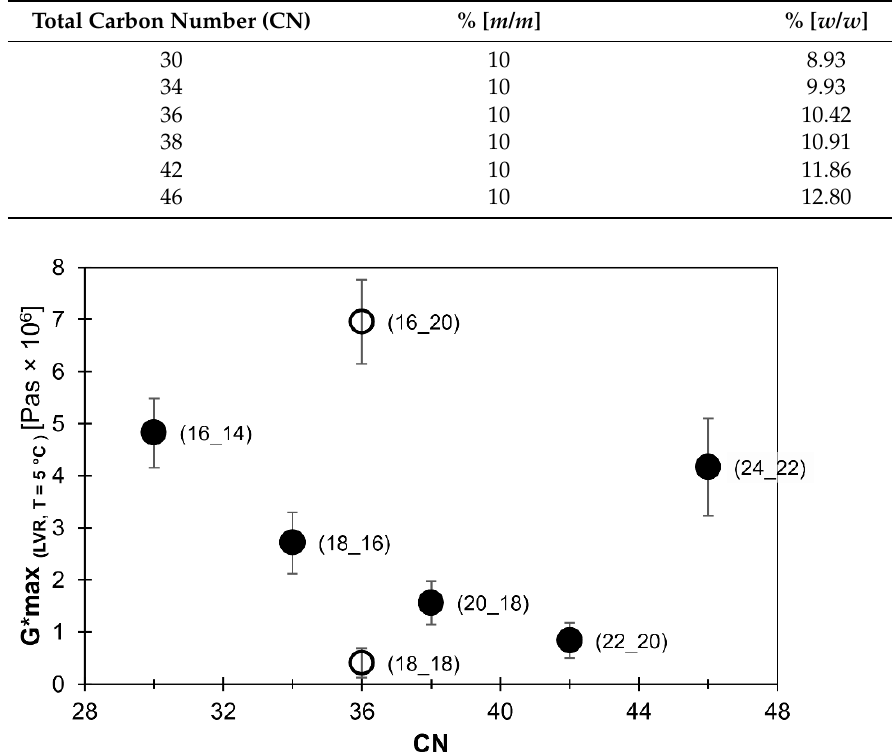
Figure 3. Maximum complex shear modulus ( 𝐺 𝑚𝑎𝑥∗ ) (in linear viscoelastic range (LVR); T = 5 °C) as a function of CN for mono-ester gels consisting of a pure WE (10% [ m / m ]) and medium chain triglycerides (MCT) oil. Filled circles: homologous series of ∆𝐶𝑁 = +2 , hollow circles: not part of homologous series. All WE are denoted as (FaOH_FA).